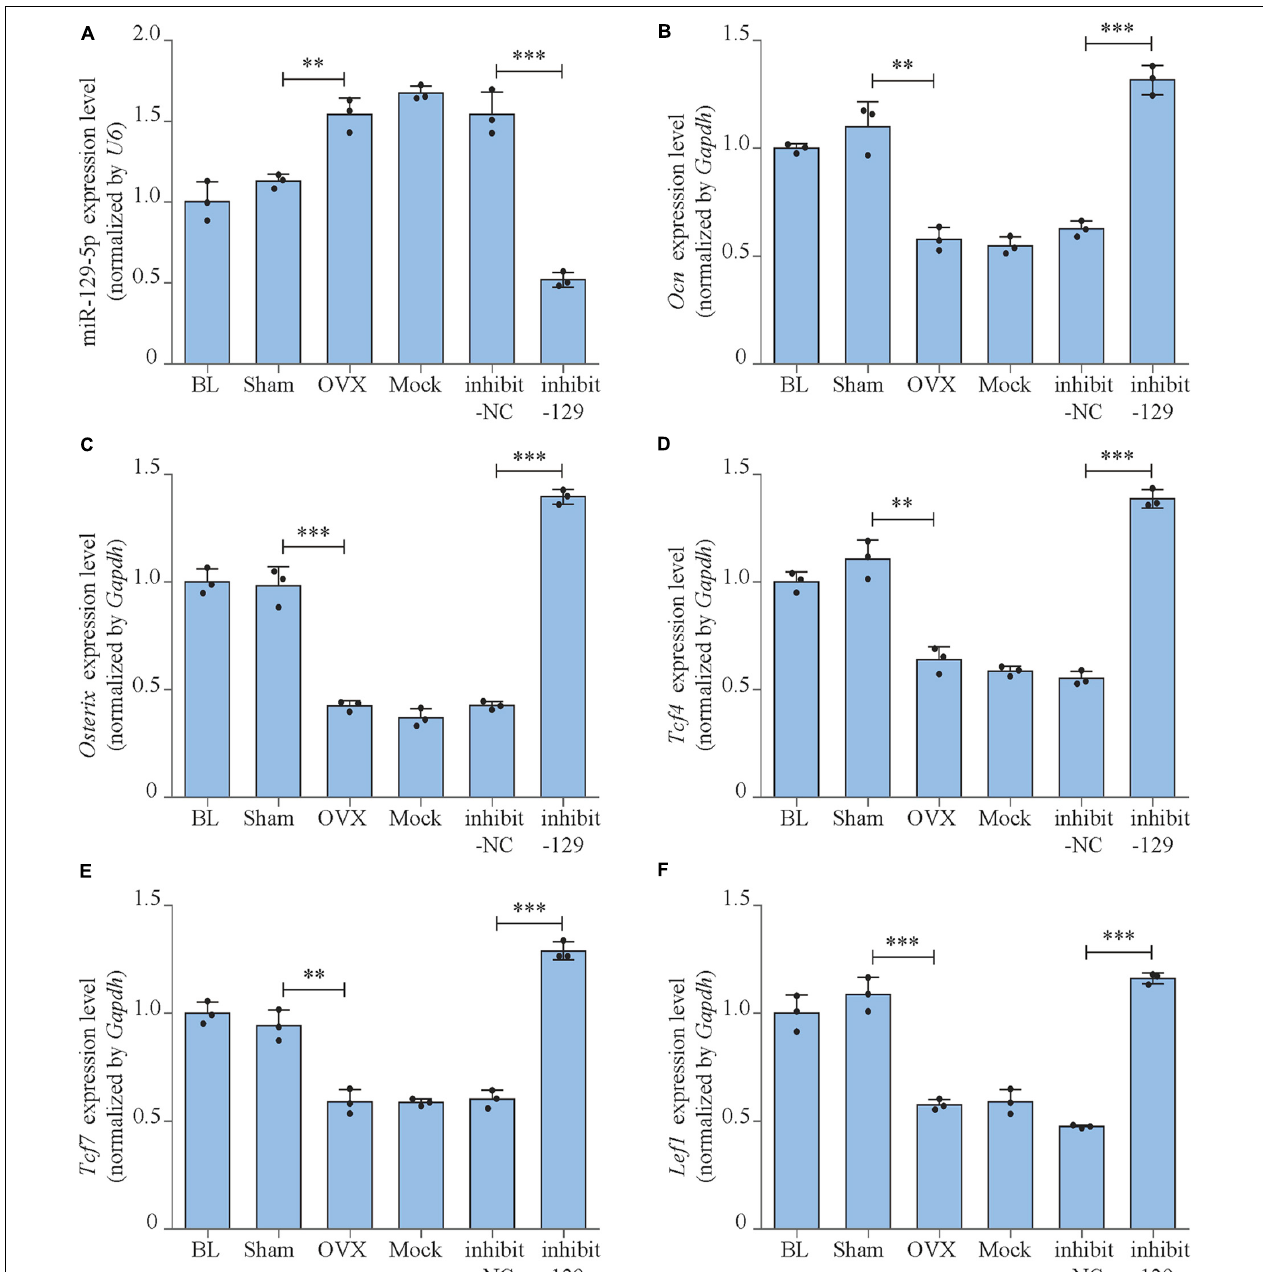
FIGURE 7 | miR-129-5p and osteogenic transcript factor expression levels of OVX mice after inhibitor-129-5p treatment. (A) miR-129-5p level in calvarial tissue of C57BL/6 mice after OVX and inhibitor-129-5p treatment, as detected by reverse transcriptase-polymerase chain reaction (RT-PCR; mean ± SD, ∗∗ P < 0.01, ∗∗∗ P < 0.001). BL (baseline): sacrifice before RNA treatment. Sham: sham OVX operation group. OVX: OVX group. Mock: transfection reagent control group. inhibit-NC: inhibitor-NC–treated group. inhibit-129: inhibitor-129-5p–treated group. (B–F) Ocn , Osterix , Tcf4 , Tcf7 , and Lef1 expression levels in calvarial tissue